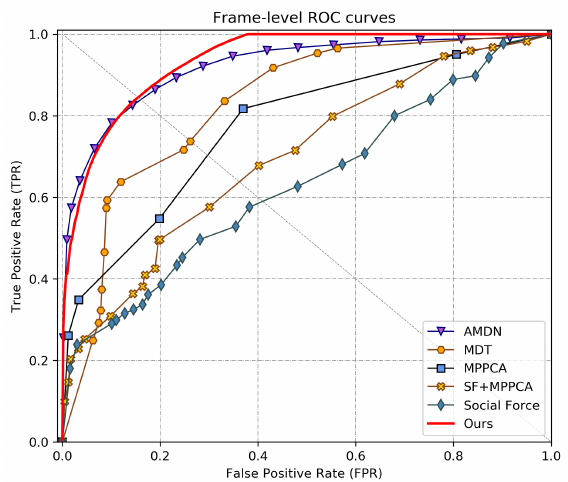
Figure 5. ROC comparison of different methods on Ped2 dataset for